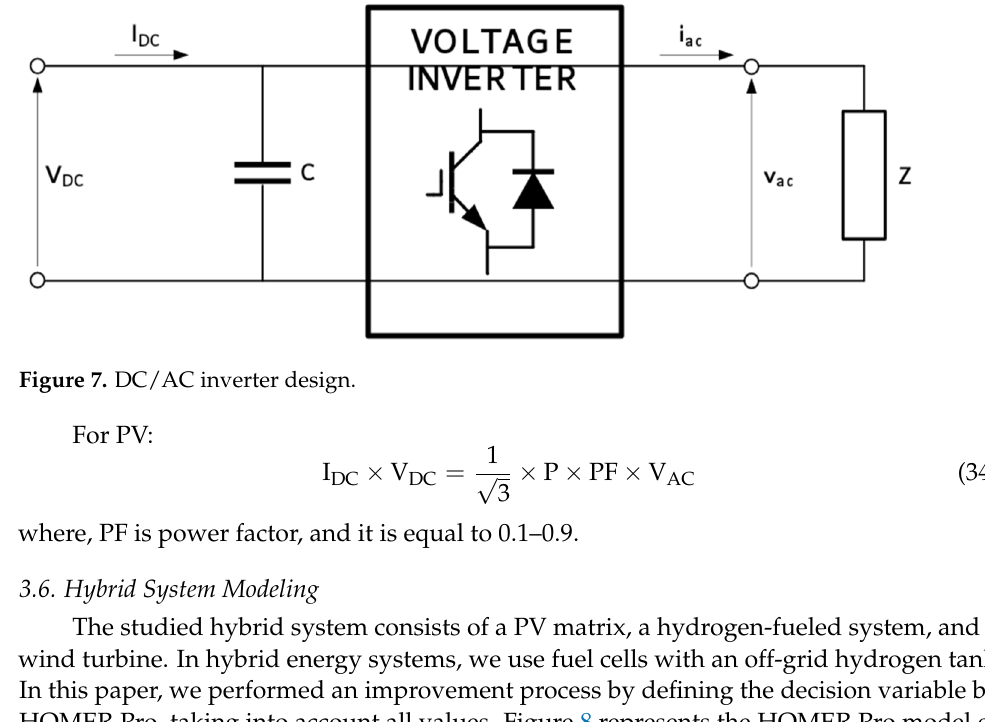
Table 4. Input data on option costs.